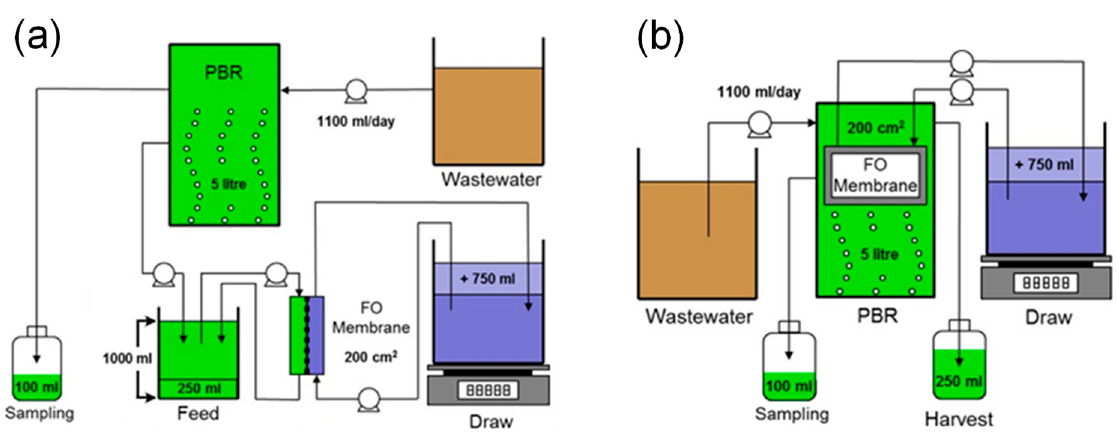
Figure 1. Schematic diagram of ( a ) side-stream and ( b ) submerged osmotic